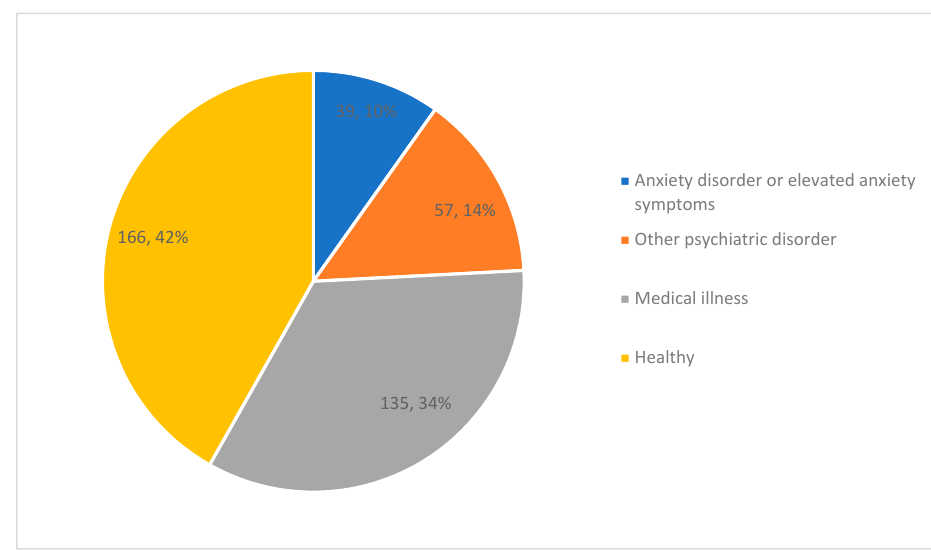
Figure 4. Participant populations in human experimental studies (count, percent).